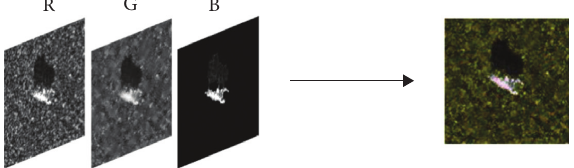
Figure 4: The fusion of multifeature